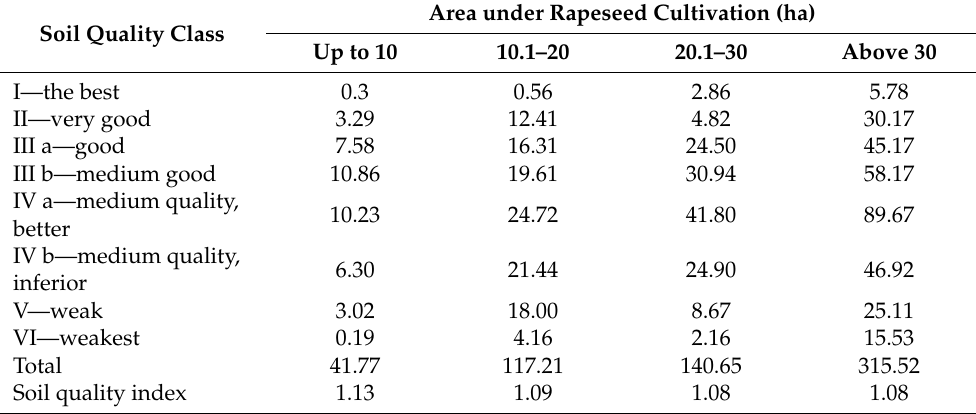
Table 1. Soil quality classes and soil quality index